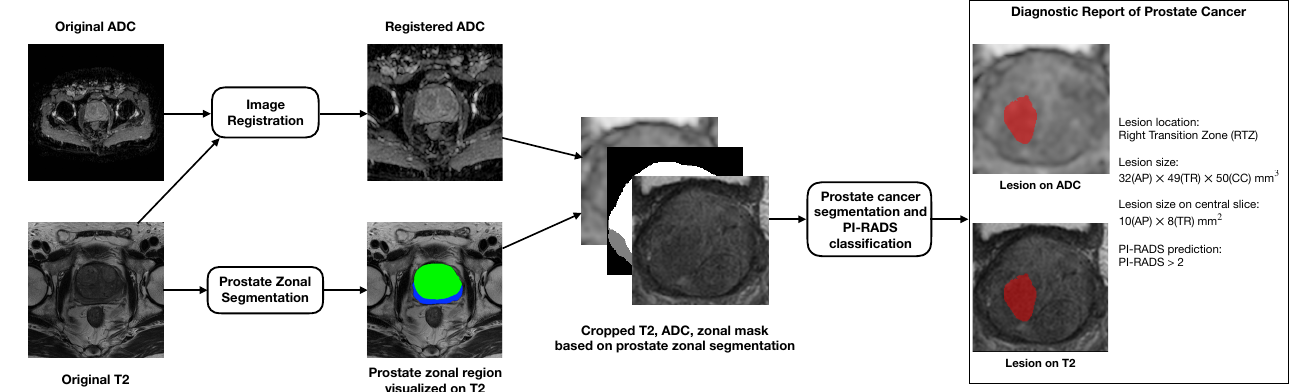
Figure 1. The overall pipeline of our work includes four main steps: (1) image preprocessing (regis- tration, normalization, etc.); (2) zonal segmentation and cropping; (3) prostate cancer segmentation and classification; and (4) diagnostic report